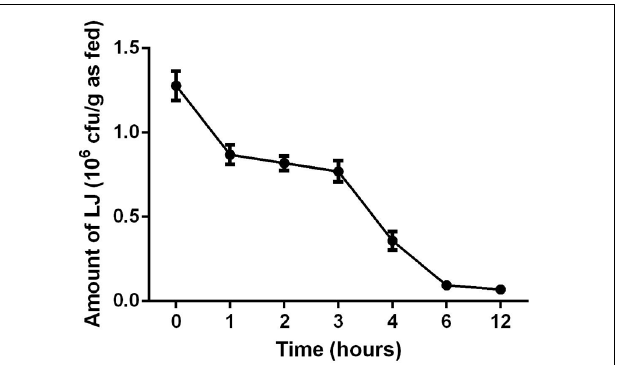
FIGURE 1 | Changes in Lactobacillus johnsonii BS15 amount from 0 to 12 h. Data are presented as mean ± standard deviation ( n = 5).